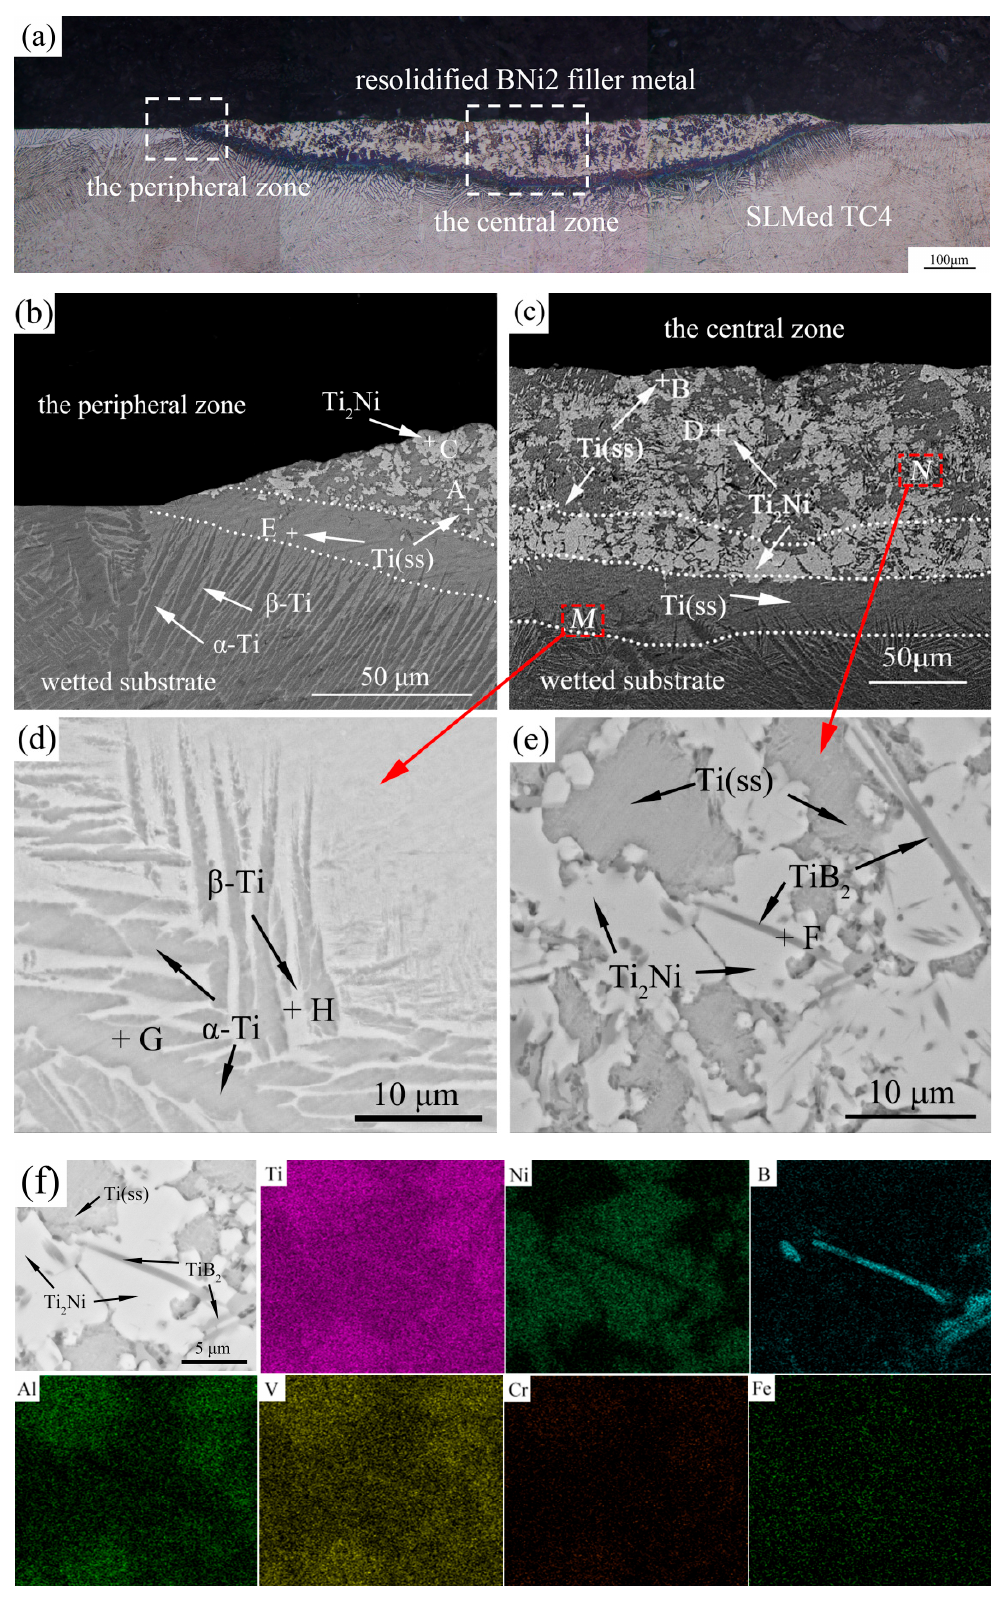
Figure 9. Typical resolidified BNi2 filler metal over the SLMed TC4 with a peak temperature of 1080 °C and dwell time of 120 s: ( a ) the optical micrograph of the whole cross-section; ( b ) the edge area of the cross-section; ( c ) the central area of the cross-section; ( d ) the magnified topography of area M in ( c ); ( e ) the magnified topography of area N in ( c ); and ( f ) EDS mapping of the partial area in Figure 9d.